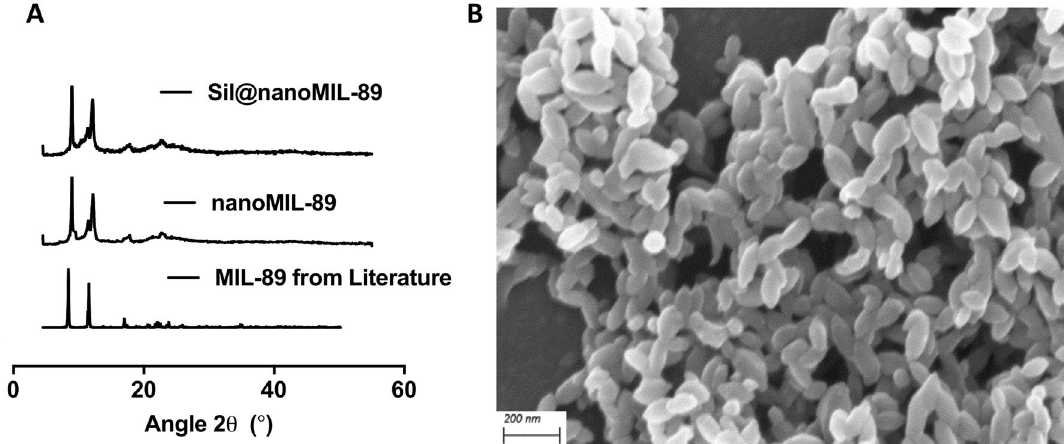
Figure 1. Characterization of nanoMIL-89. ( A ) Powder X-ray Diffraction (PXRD) analysis of nanoMIL-89 prepared within the reported study, MIL-89 reported in literature 20 and nanoMIL-89 loaded with sildenafil (Sil@